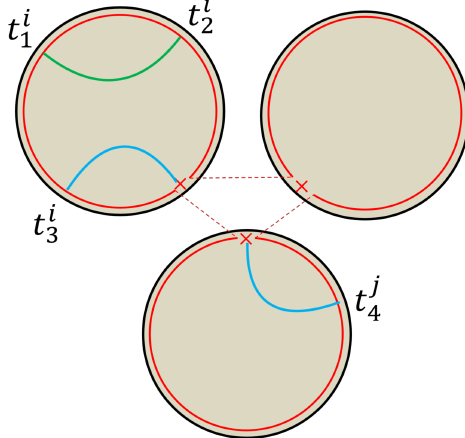
Figure 5 . Illustration of the Euclidean bulk geometry for n replica of the averaged thermal state. The red circles represent the boundary of each replica with perimeter β . n replica of hyperbolic disks (with n = 3 in the figure) are glued at a branching point (red cross) at the boundary. The points connected by the red dashed lines are identified. The green and blue curves are geodesics that contribute to the same-replica two-point function G (cid:16) (cid:17) function G t i , t j , 3 4